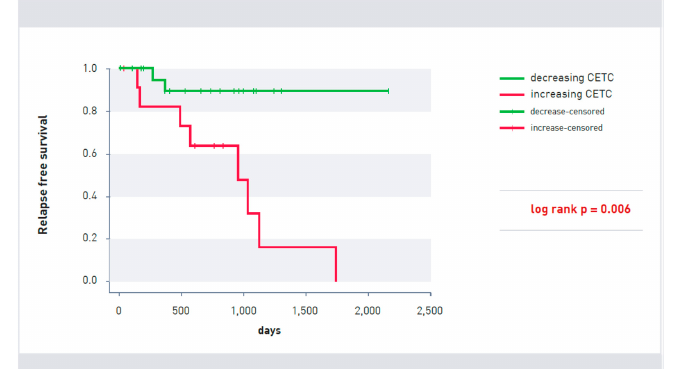
Figure 2. Kaplan-Meier survival curve of patients with increasing (red line) and decreasing (green line) CETCs ( p = 0.006). Patients without signs of relapse at the last visit were censored. Established prognostic factors such as tumor size or nodal status were not predictive of prognosis nor were age in this patient population after the end of endocrine therapy. While tumor size indicated a tendency ( p = 0.058; Figure 3a) for tumors bigger than T1 size to have a poorer prognosis (only one patient had a tumor bigger than T2), neither the nodal status (Figure 3b) nor age (Figure 3c) was significant for recurrence-free survival after endocrine therapy in this small patient cohort.